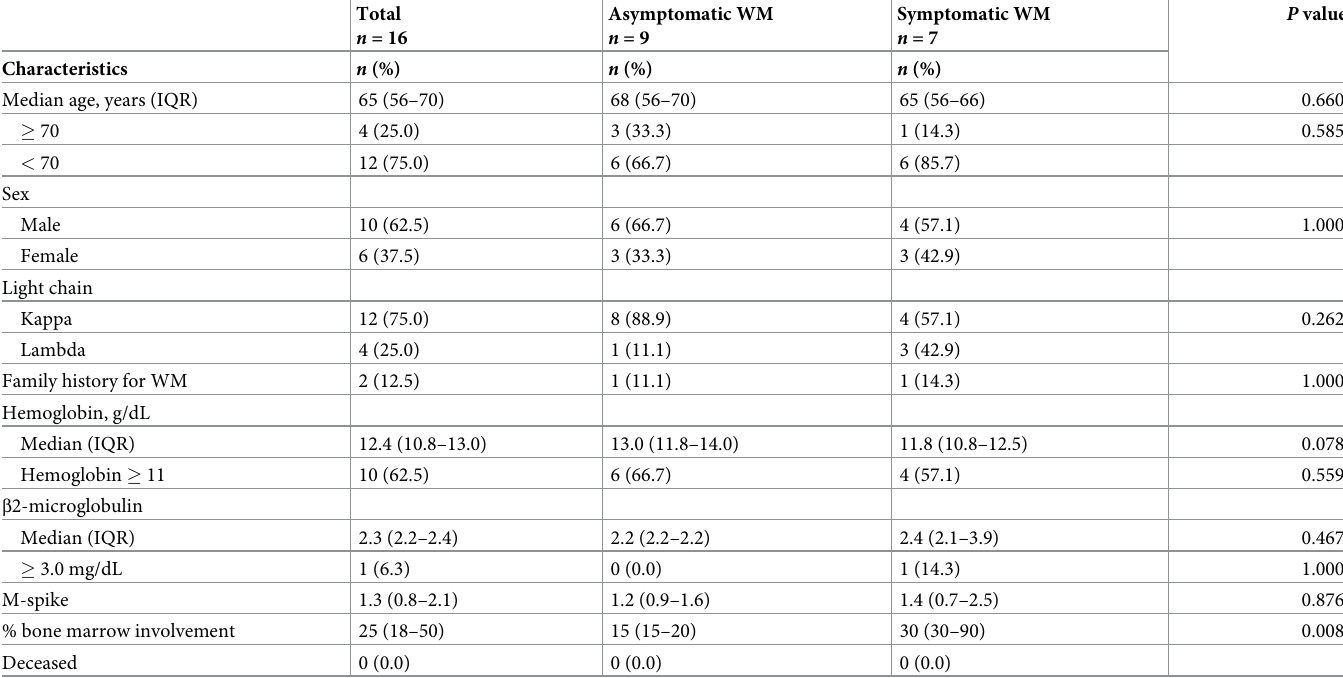
Table 1. Clinical characteristics of Waldenstro¨m Macroglobulinemia patients–TaqMan Array Human MicroRNA A